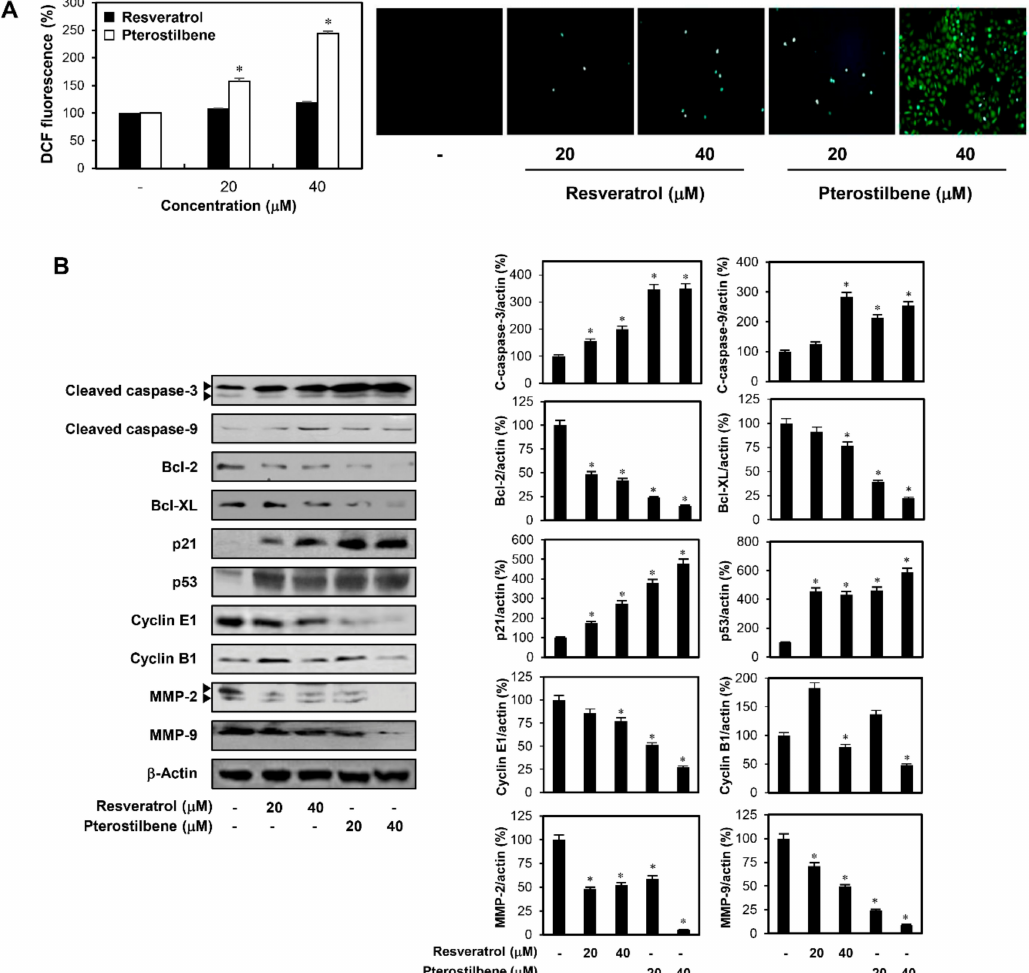
Figure 5. Identification of molecular mechanisms underlying the growth and migration inhibitory e ff ects of resveratrol and pterostilbene in HeLa cells. ( A ) The e ff ects of resveratrol and pterostilbene on reactive oxygen species (ROS) generation in HeLa adherent cells. The cells were treated with resveratrol and pterostilbene (20 and 40 µ M) for 48 h. Intracellular ROS levels were detected with 2 (cid:48) ,7 (cid:48) -dichlorofluorescein diacetate (DCFH-DA). ( B ) The e ff ects of resveratrol and pterostilbene on the expression of cleaved caspase-3, cleaved caspase-9, Bcl-2, Bcl-XL, p21, p53, cyclin E1, cyclin B1, MMP-2, and MMP-9 in HeLa adherent cells. The cells were treated with the two compounds (20 and 40 µ M) for 48 h, and the protein levels were detected by Western blot analysis using specific antibodies. The levels of β -actin were used as an internal control. Arrowheads indicate true bands for the molecular markers. * p < 0.05 versus the